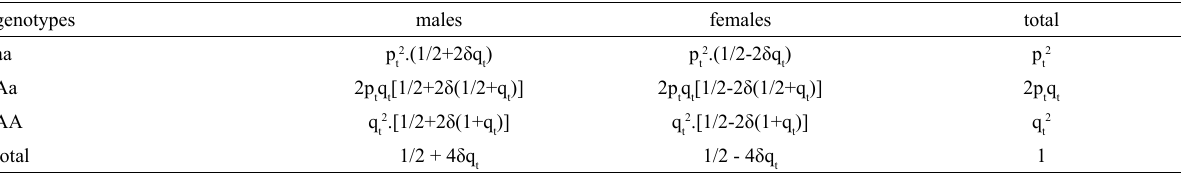
Table 2 ‒ Progeny AA, Aa and aa genotype frequencies among males and females after one generation of random crossings (model 2).